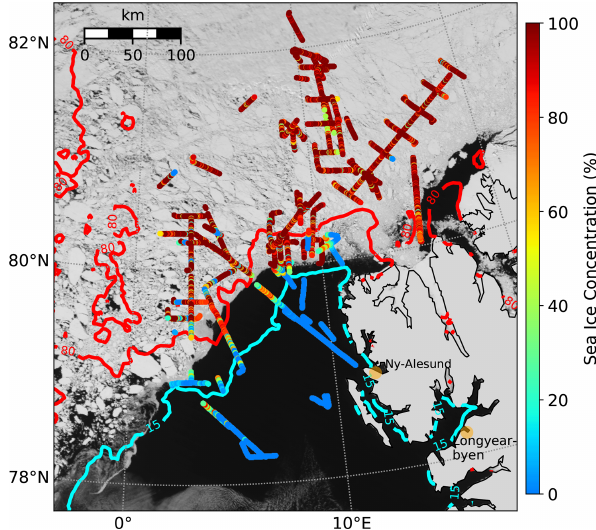
Figure 1. MODIS satellite image on 1 June 2017, representing the typical sea ice distribution during the ACLOUD campaign. All low-level flight sections during the ACLOUD campaign are indi- cated with the sea ice fraction derived from airborne observations. Red (80%) and light-blue (15%) contours indicate the campaign- average sea ice fraction from daily satellite-based sea ice data (Spreen et al.,